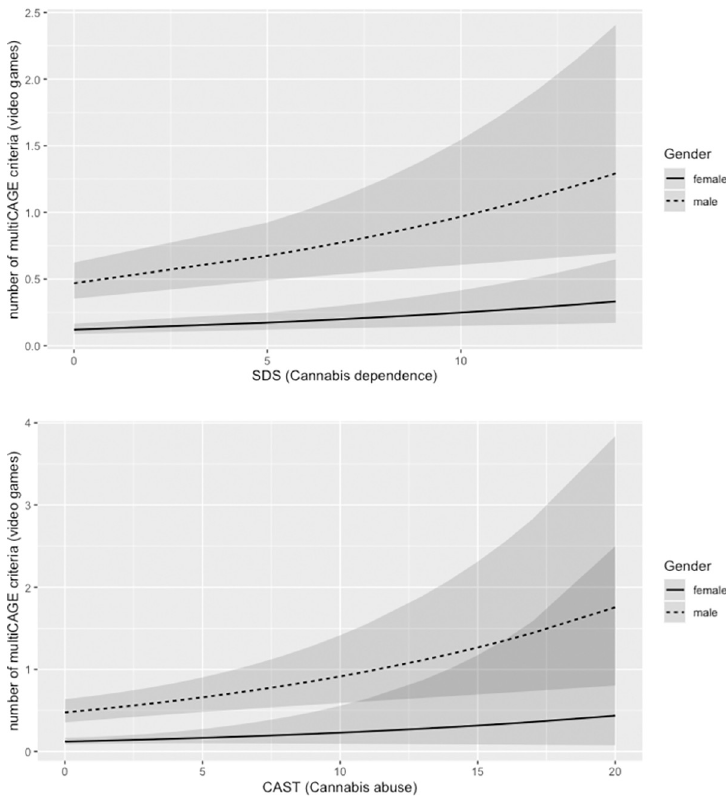
Fig 1. Predicted incidents (number of video games MultiCAGE items endorsed) as a function of cannabis dependence (panel A) and abuse (panel B), and gender.